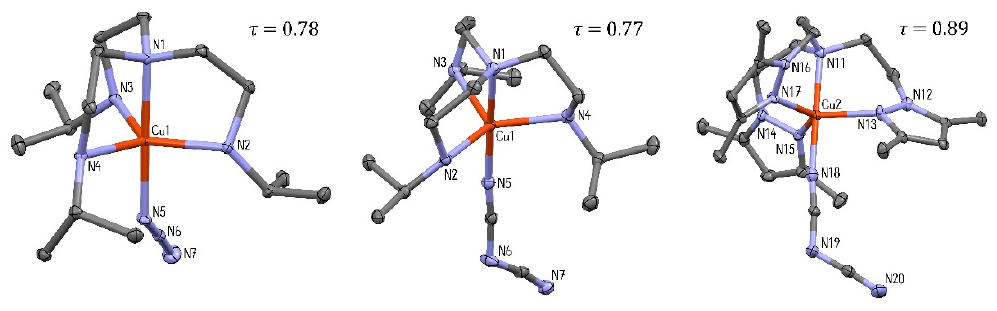
Figure 2. Perspective views of complex cations of 3 ( left ), 4 ( center ), and 6 ( right ). θ and ϕ bond (°) used for calculation of τ -values: 3 : N5-Cu1-N1 179.28(7); N2-Cu1-N3 132.54(6); 4 : N5-Cu1-N1 176.21(14), N2-Cu1-N4 129.85(14); 6 : N1-Cu1-N8 176.0(2), N3-Cu1-N7 128.2(2); N11-Cu2-N18 178.4(2), N15-Cu2-N17 125.3(2); and N21-Cu3-N28 176.7(2), N23-Cu3-N27 127.8(2).